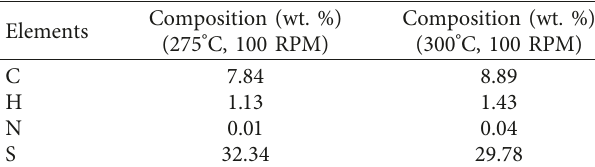
Table 4: CHNS Analysis data for hard